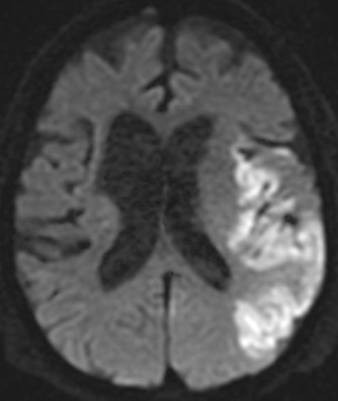
Diffusion-weighted image of the brain MRI taken on day 9 with high intensity areas on the left middle cerebral artery region.